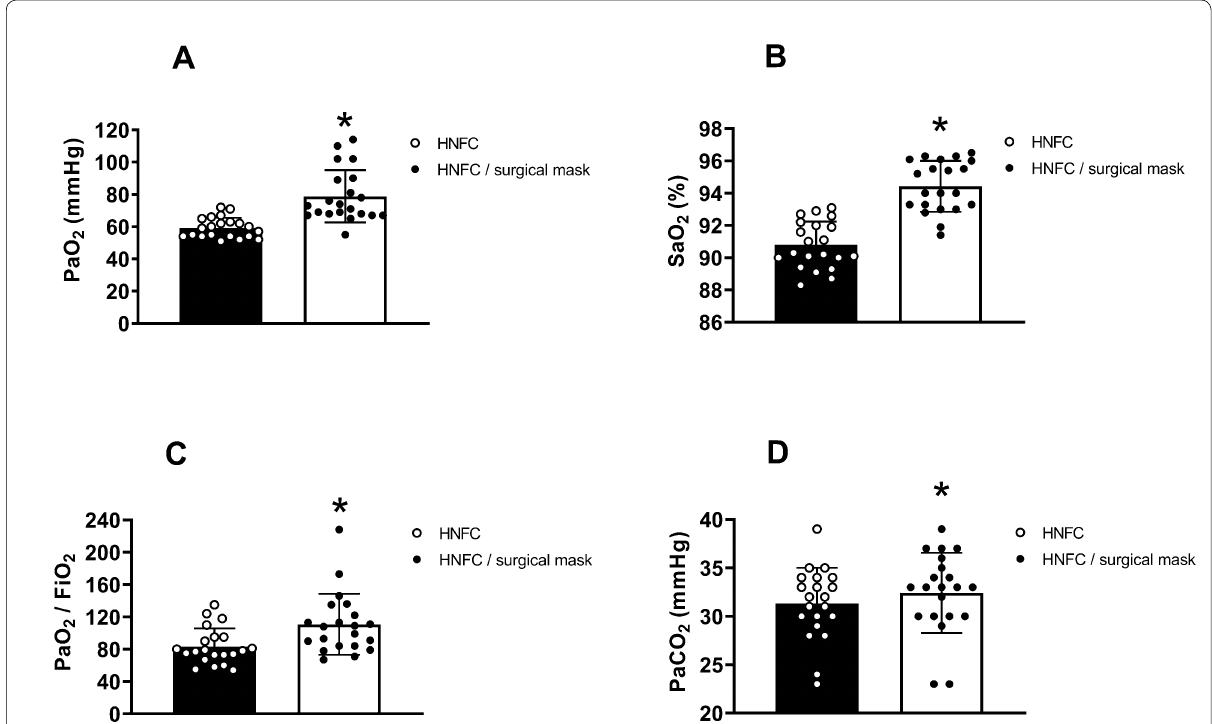
Fig. 1 Respiratory parameters with high‑flow nasal cannula (HFNC) alone and in the presence of a surgical mask (HFNC/surgical mask). These data showed an improvement in all variables. * p < 0.05 compared to HNCF alone in paired t